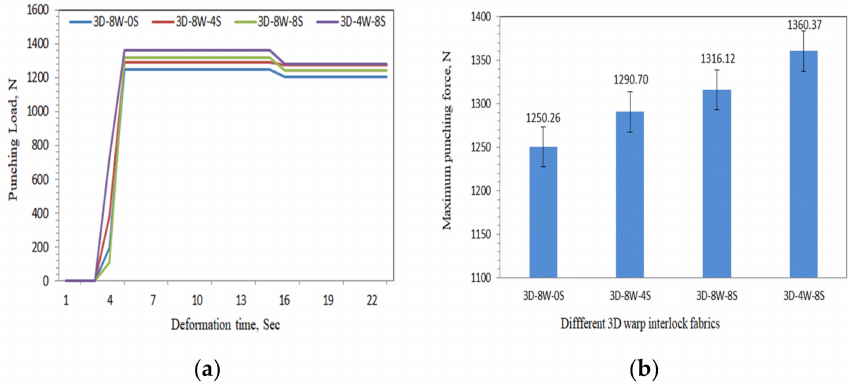
Figure 7. ( a ) The punching forces versus the deformation time curves and ( b ) their maximum mean values of punching forces for the di ff erent 3D warp interlock